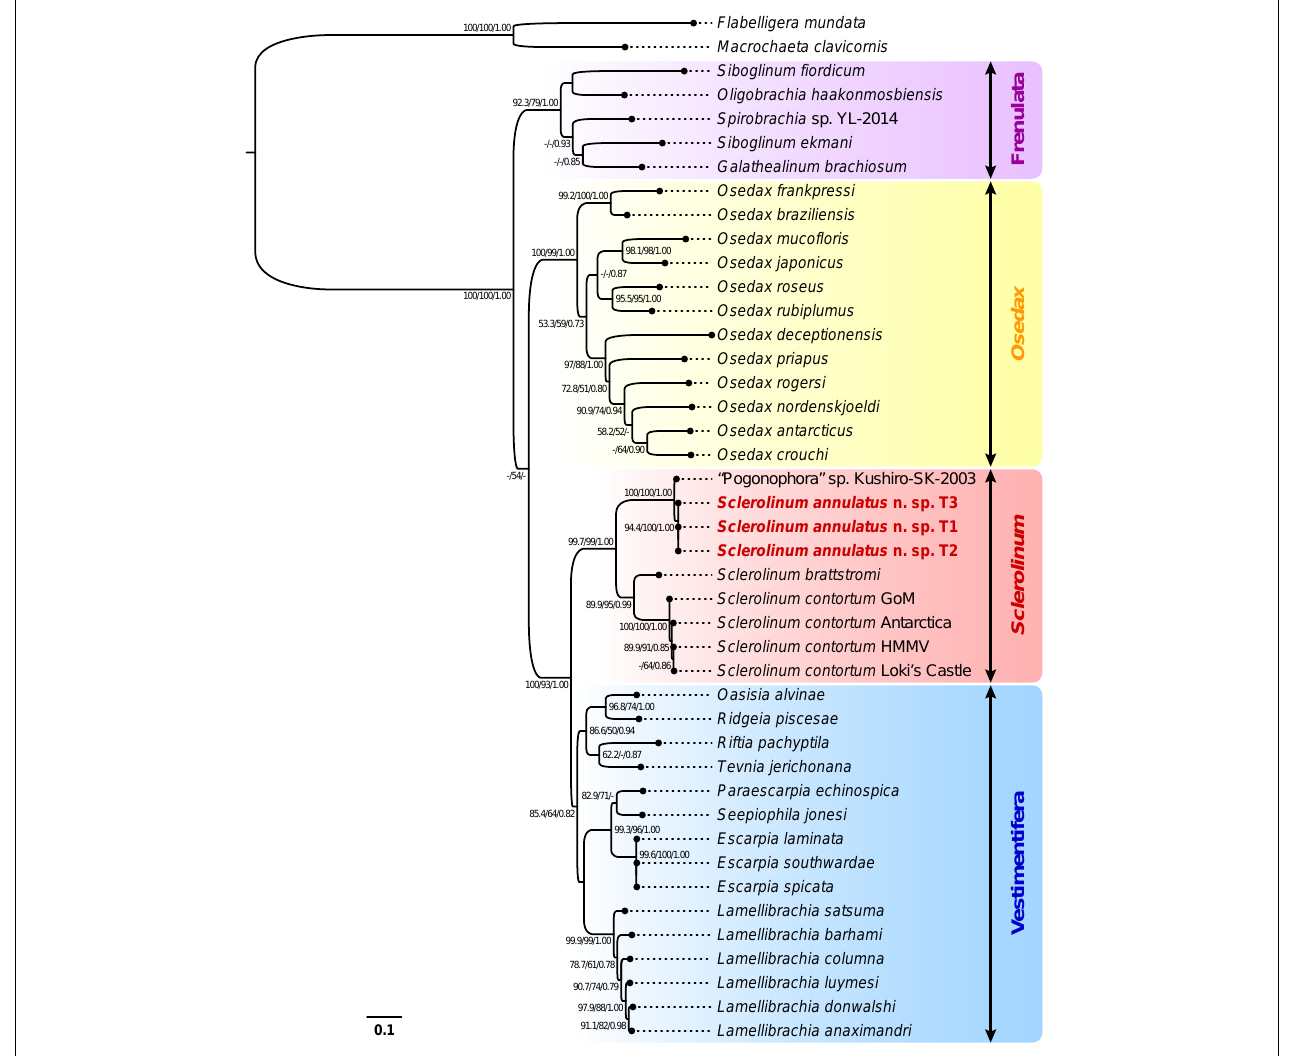
FIGURE 7 | A phylogenetic tree of siboglinid tubeworms based on the maximum-likelihood (ML) topology inferred from a 1,187-bp gap-containing alignment of the cox1 gene. Bootstrap values from the Shimodaira-Hasegawa-like (SH-like) approximate likelihood ratio tests and the standard non-parametric bootstraps (NB) of the ML analysis, as well as the posterior probabilities from the Bayesian inference (BI) analysis, are shown at nodes (ML-SH/ML-NB/BI). Dashes (-) indicate bootstrap values < 50 or posterior probabilities < 0.70. Scale bar: the number of substitutions per site. GoM, Gulf of Mexico; HMMV, Haakon Mosby Mud Volcano.